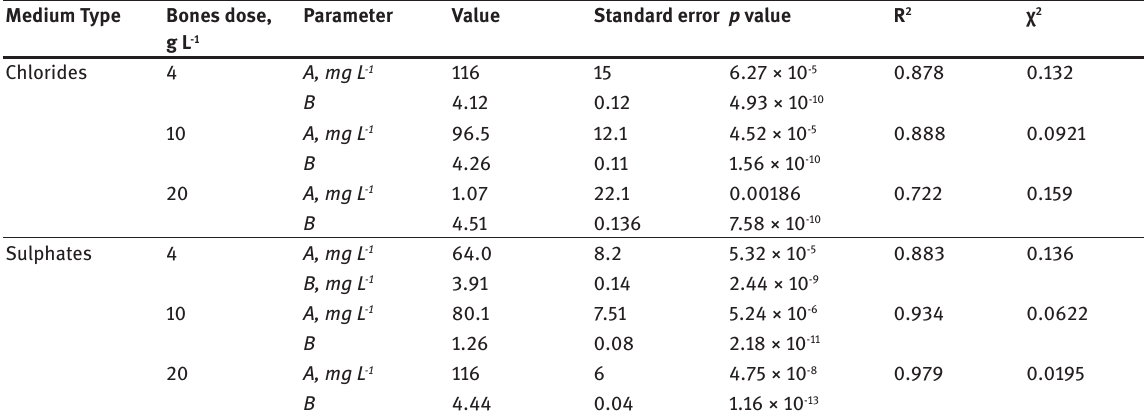
O concentrations during the solubilization 2 5